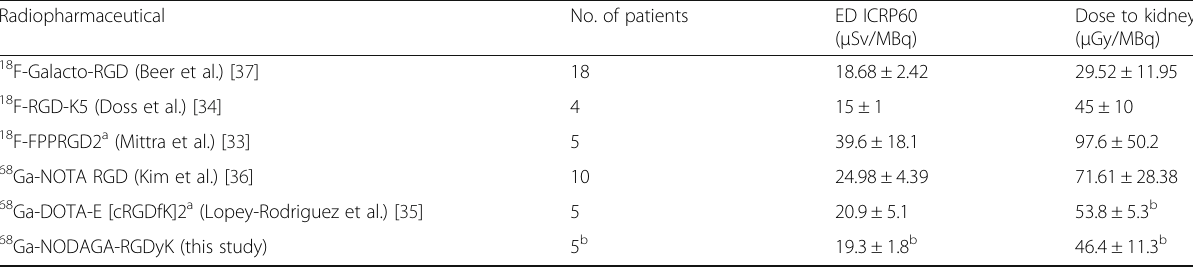
Table 4 Comparison of effective doses (ED) according to ICRP60 and absorbed doses to kidneys between available studies on RGD- based radiopharmaceuticals assuming 1-h voiding cycle. Mean ± SD are reported